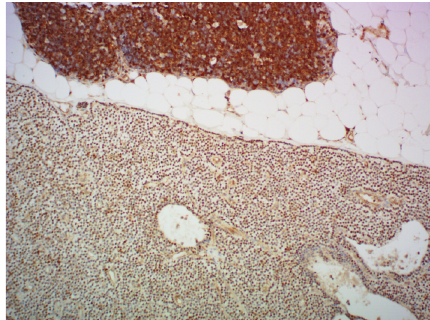
Figure 1: Immunohistochemical staining for p27 (original magnifi- cation × 100). Positive nuclear staining for parathyroid adenoma in lower half and positive nuclear staining for thymic lymphocytes in upper